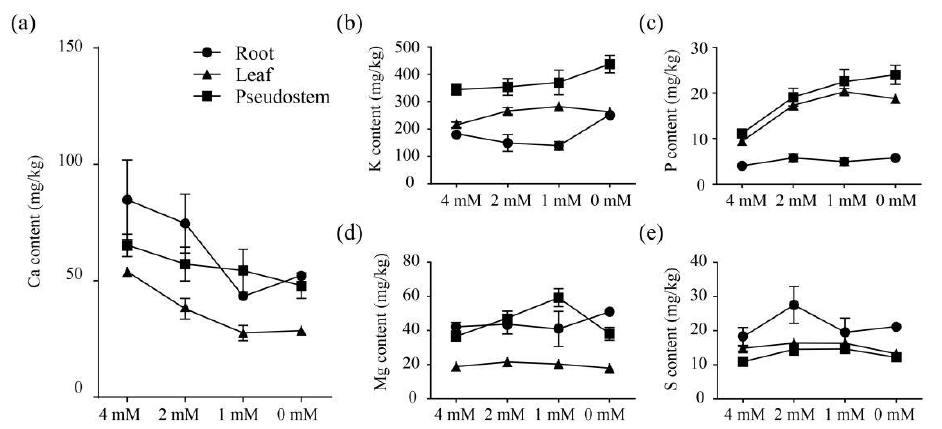
Figure 7. Effect of the different concentrations of Ca 2+ on Ca ( a ), K ( b ), P ( c ), Mg ( d ) and S ( e ) content in root, leaf and pseudostem of banana seedlings. All data are displayed as mean ± standard devia- tion (SD) of at least three replicates.